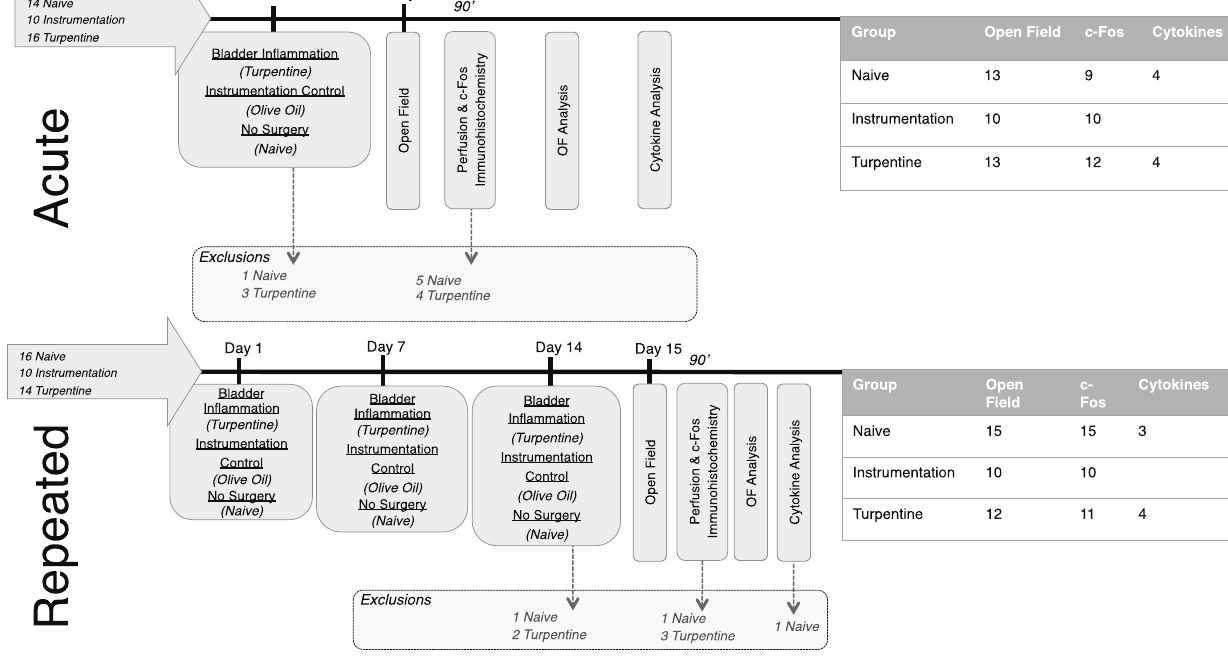
Figure 1. Experimental design for both acute and repeated models. The arrows on the right show the total number of animals used, with exclusions at each timepoint and final group sizes indicated in the central and right of the diagram respectively. Animals were lost during surgery due to complications associated with anaesthesia, and excluded from immunohistochemical analysis if hemispheric differentiation was not